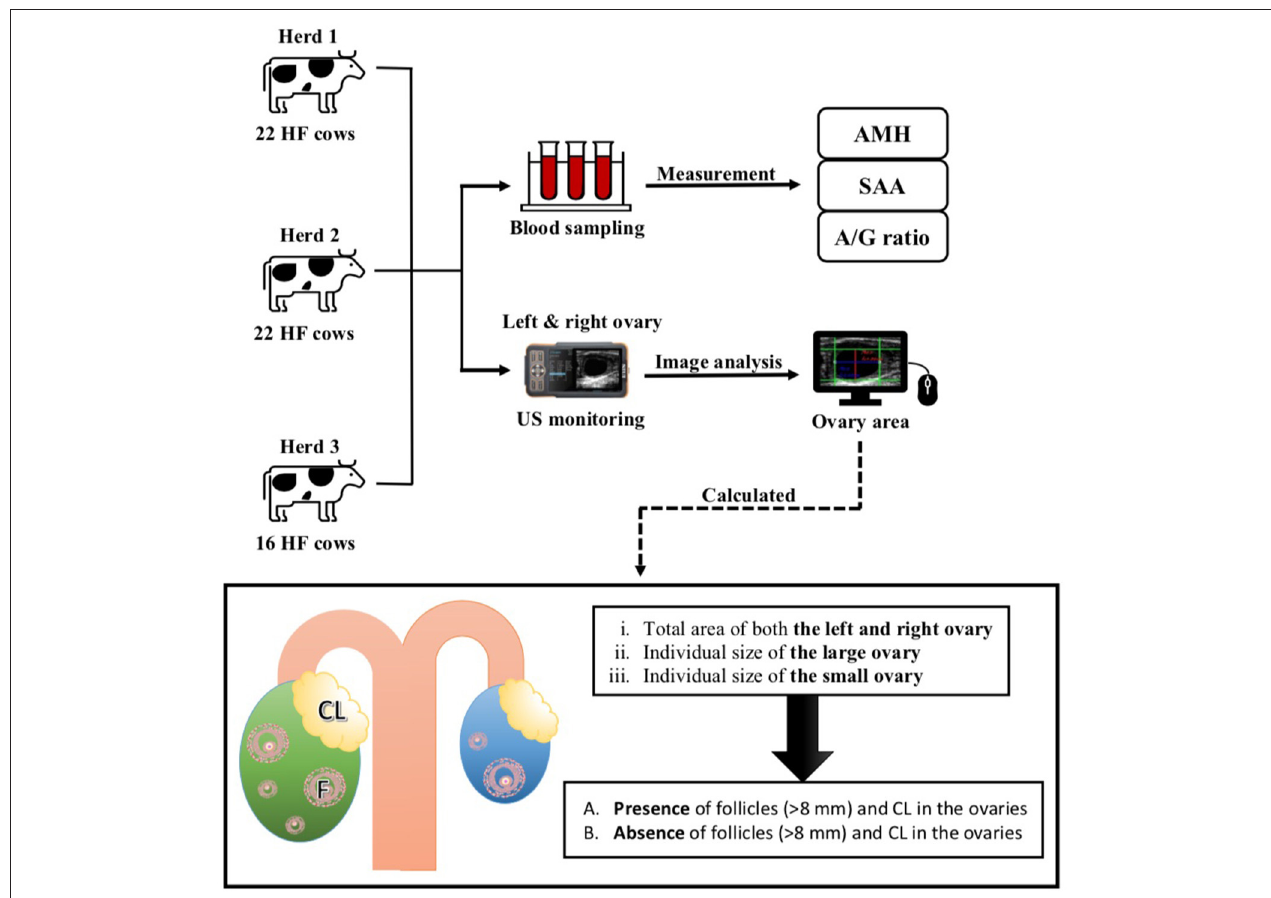
FIGURE 1 | Experimental protocol of the present study. US, Ultrasound monitoring; HF, Holstein–Friesian; AMH, anti-Müllerian hormone; US, Ultrasonography; SAA, Serum amyloid A.